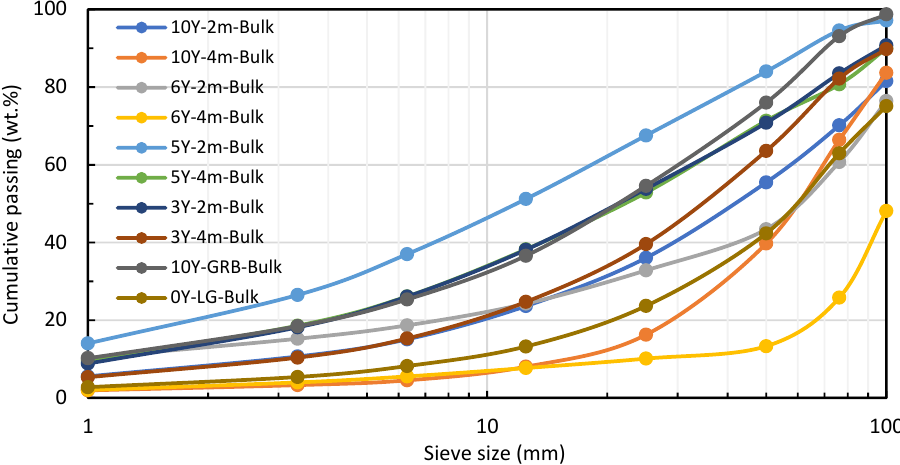
Figure 4. Cumulative particle size distribution of the bulk samples. Table 5. Copper content (wt. %) of the bulk samples by size fraction.